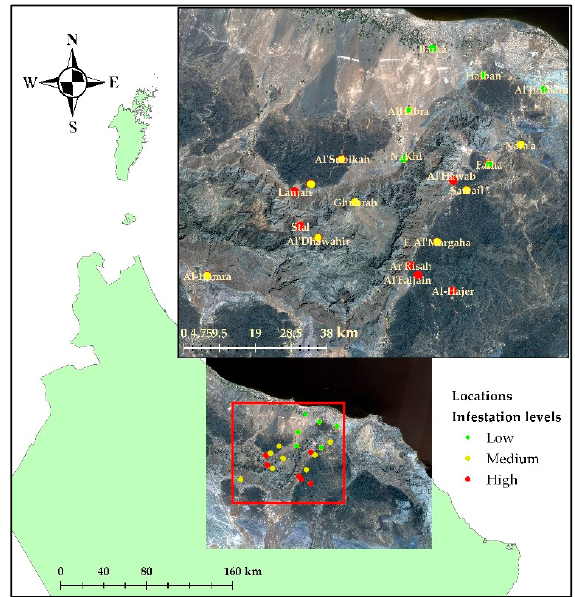
Figure 1. Map of north Oman showing the study area within Oman, the point of each field and the average infestation levels over four seasons.